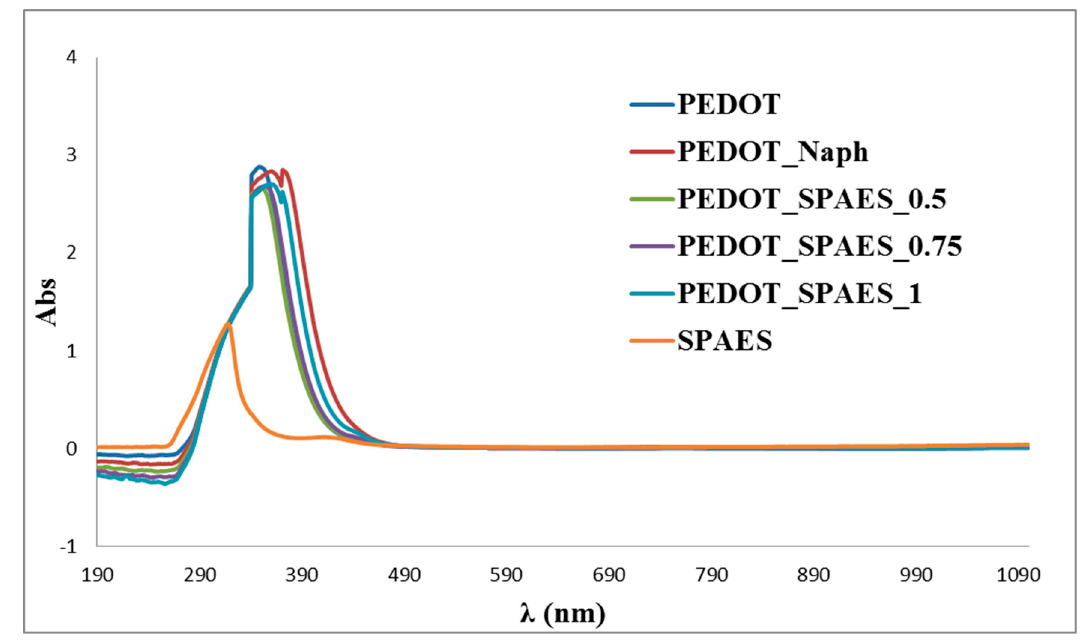
Figure A9. UV absorbance data of PEDOT, PEDOT_Naph, PEDOT_SPAES, and SPAES samples synthesized in DMSO.